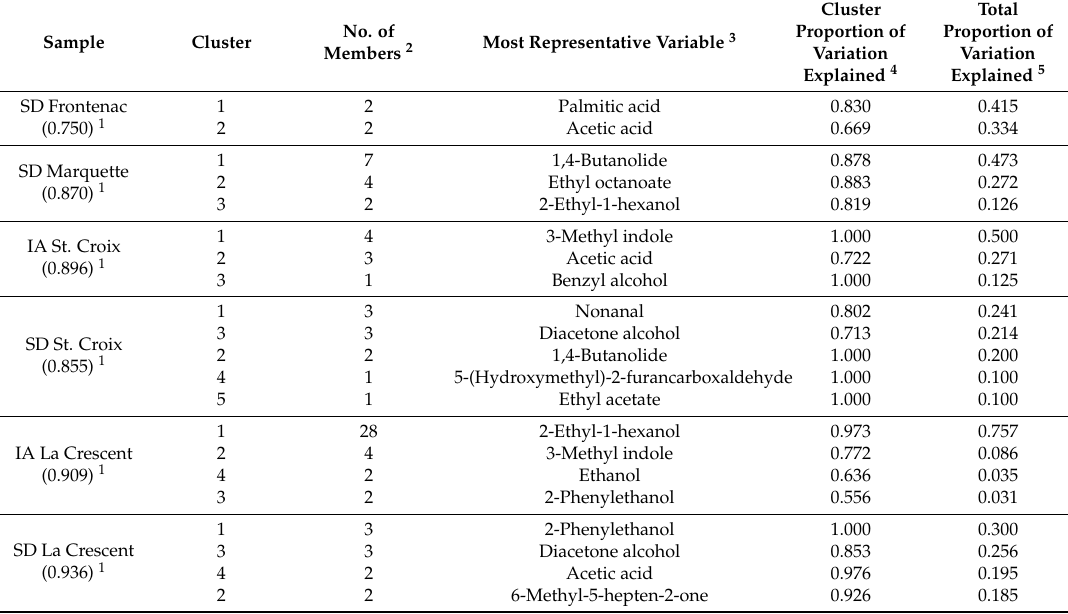
Table 2. ‘Characteristic’ VOCs emitted from single berries of Frontenac, Marquette, St. Croix, and La Crescent grapes grown in Iowa and South Dakota. These VOCs were indicated to be the most representative variable from hierarchical clustering analysis after the PCA (JMP Pro 12.0.1, SAS Institute Inc., Cary, NC,